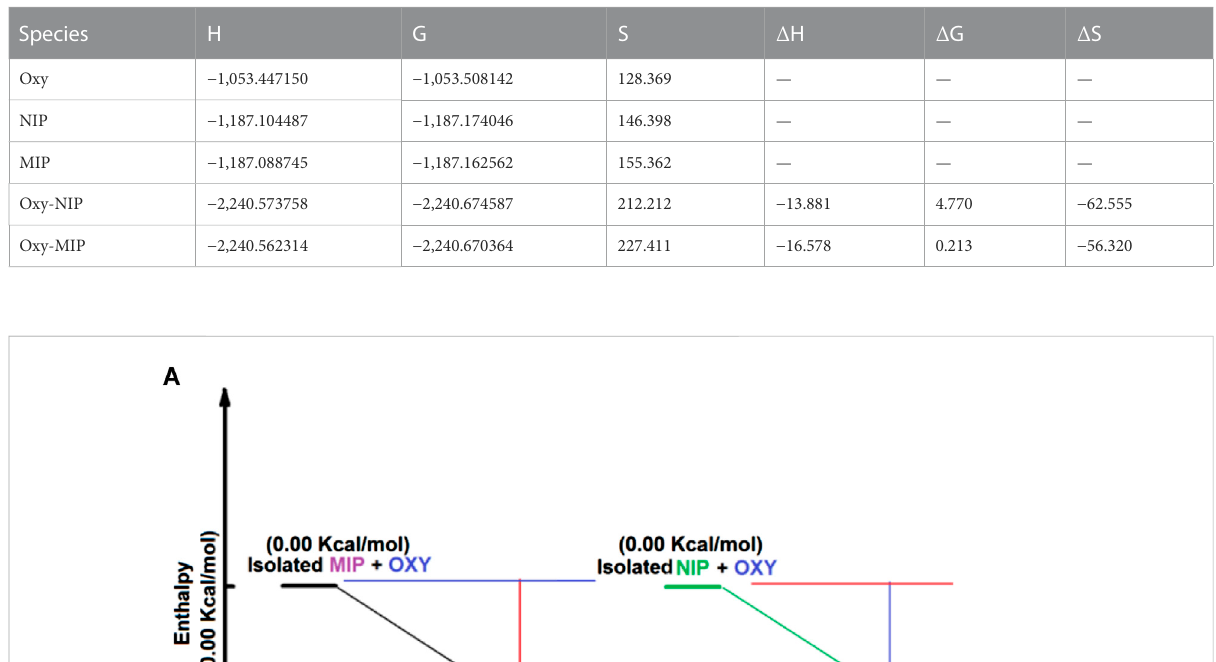
nanoparticles from the different concentrations of the standard solution prepared from blood plasma. First observable outcome of the data is the considerably higher ability of the MIP compared to NIP in adsorption of the drug. Somehow, at the least concentration (10 μ g ml − 1 ), the